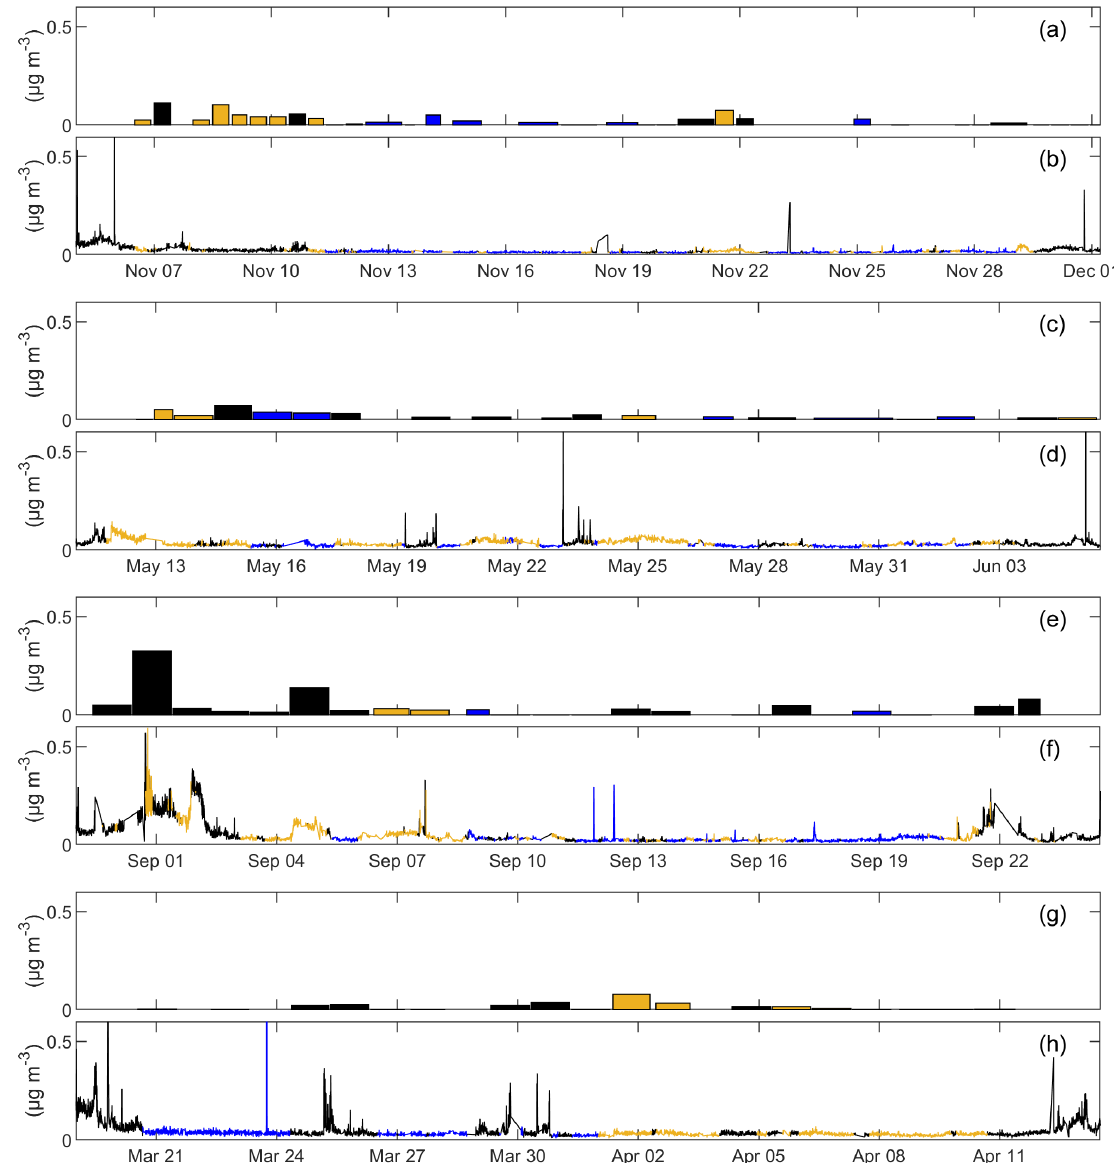
Figure 1. Time series of AMS NR amine fragments measured by the HR-ToF-AMS (b, d, f, h) and FTIR NV amine groups measured by FTIR spectroscopy in particles with diameters < 1µm (a, c, e, g) for all four cruises: winter (a, b) , late spring (c, d) , autumn (e, f) , and early spring (g, h) . Marker colors represent the air mass type: blue – marine, yellow – continental, and black – winds abaft or mixed.